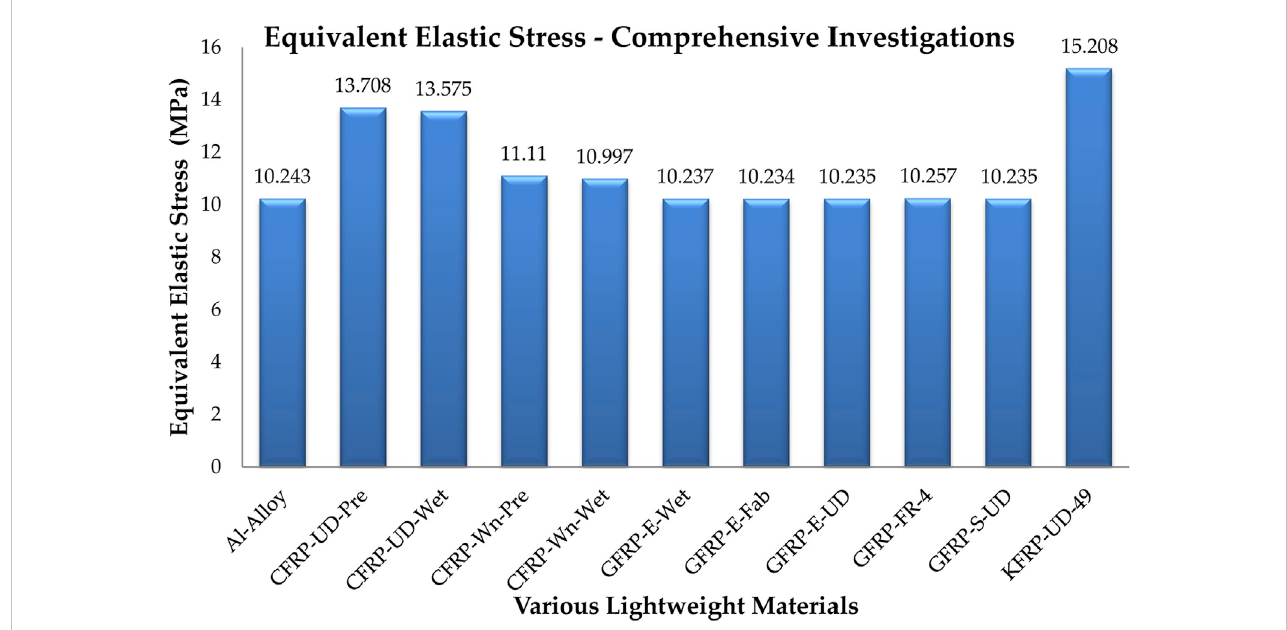
Comprehensive report of equivalent elastic stress of main rotor of RUAV.